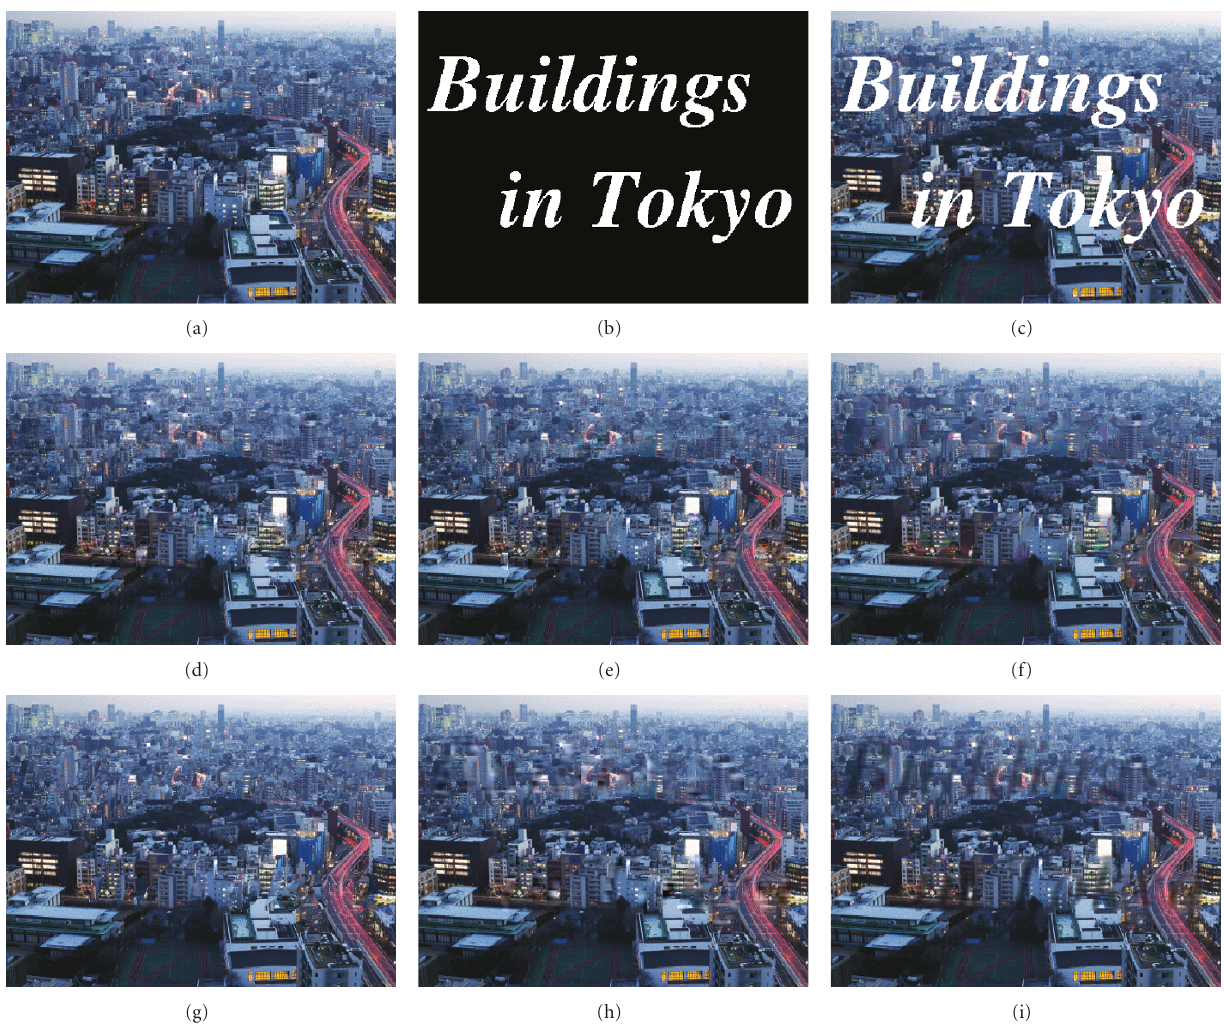
Figure 4: (a) Original image (480 × 360 pixels, 24-bit color levels). (b) Flag image whose white regions correspond to missing areas. (c) Corrupted image including text regions (10.7% loss). (d) Reconstructed image by the proposed method. (e) Reconstructed image by the method based on the random selection. (f) Reconstructed image by the method which utilizes the MSE instead of the SSIM index. (g) Reconstructed image by the conventional method [11]. (h) Reconstructed image by the conventional method [13]. (i) Reconstructed image by the conventional method